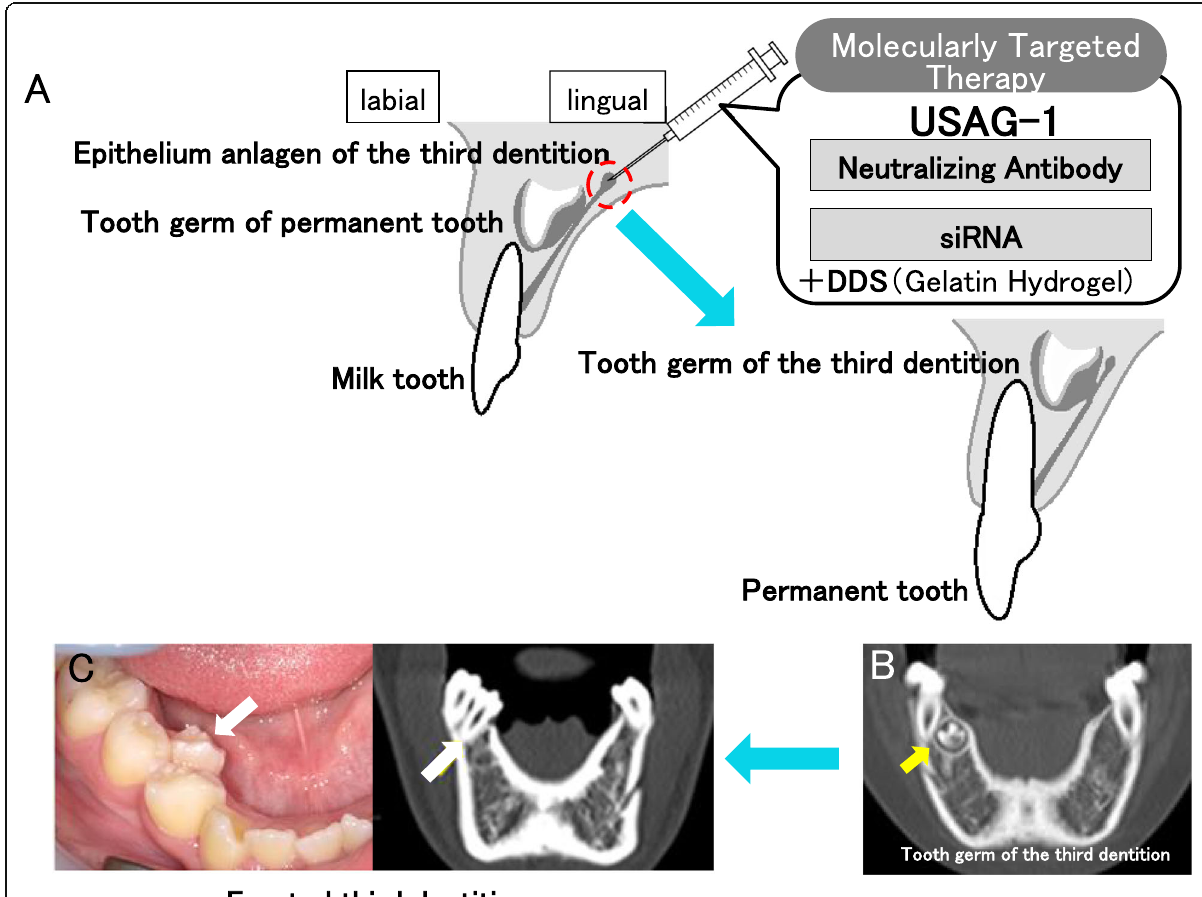
Fig. 3 Tooth regeneration by stimulation of the third dentition. a This treatment involves regenerating the third dentition following permanent teeth eruption by locally administering a neutralizing antibody or siRNA with DDS like cationic gelatin hydrogel for USAG-1. b Frontal section of a computerized tomography (CT) scan of the tooth germ of the third dentition located in the lingual side of the lower right premolar that is preceding the permanent molar in an 11-year-old individual. The yellow arrow indicates the tooth germ of the third dentition. c Occlusal view and frontal section of a CT scan of the erupted third dentition in an 18-year-old individual. The white arrows indicate the erupted third